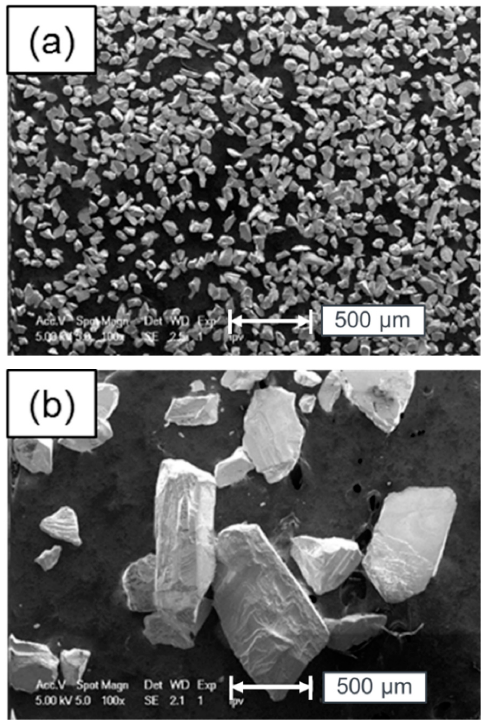
Figure 8. Same CdTe powders as in Figure 1a, b but after leaching in aqueous solution with pH4 for t = 274d. ( a ) In the CdTe 250 powder, the smaller particles disappear (compared with Figure 1a), leaving back particles with diameters d 250,274d ≈ 100 µ m. ( b ) In the CdTe 840 -powder, the small particles are dissolved fast, leaving back mainly particles with d 840,274d > 100 µ